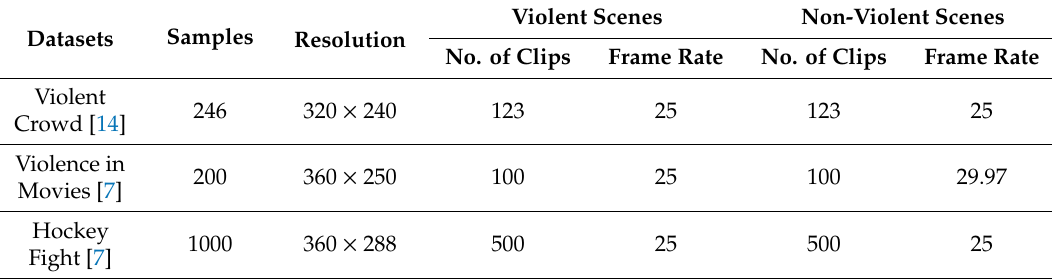
Table 2. Detailed description and statistics of the used datasets.